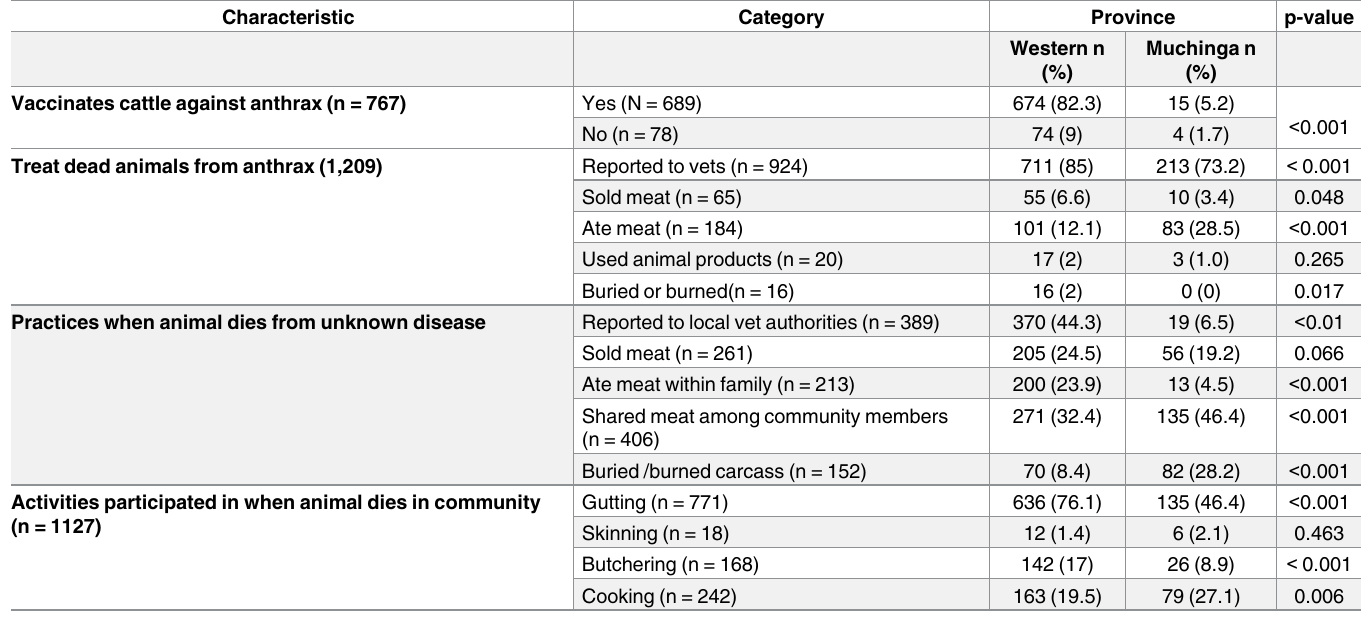
Table 3. Community practicesof relevancefor anthrax in the two provinces, reported as numbers (%) in each province.